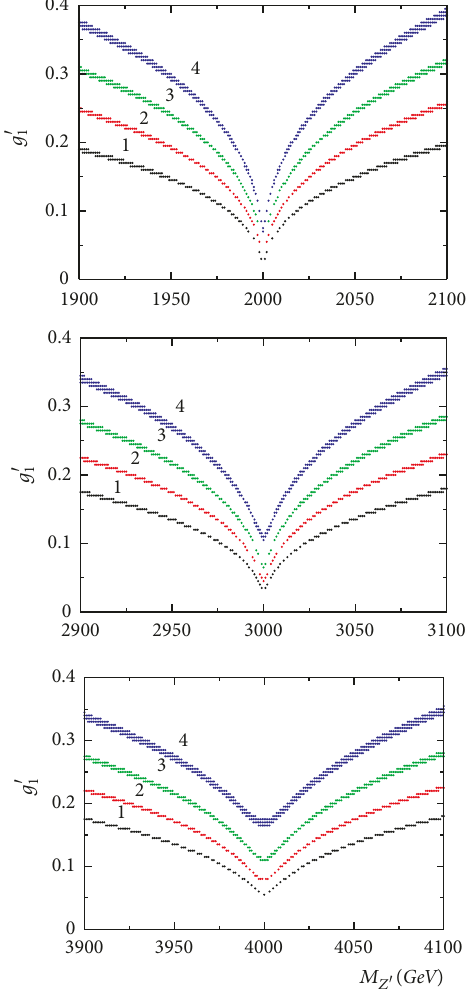
Figure 9: Same as in Figure 5, but for 𝑒 + 𝑒 − 󳨀→ 𝑡𝑡𝐻 .